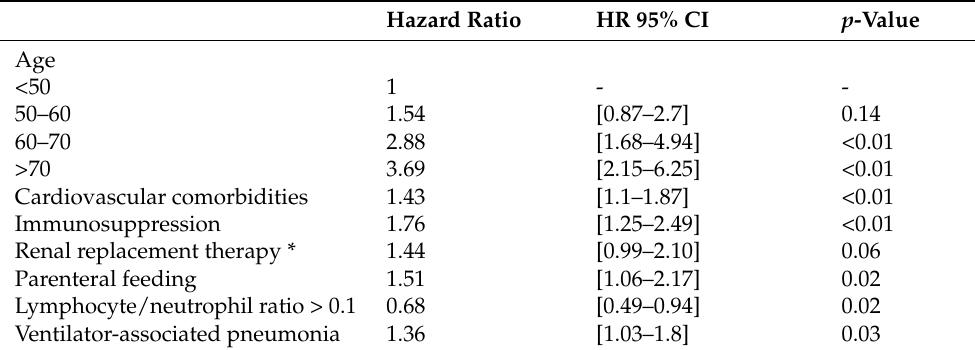
Table 3. Risk factors associated with 60-day mortality, using a Cox’s survival model (multivariate